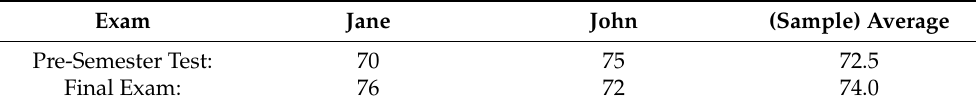
Table 1. Student score